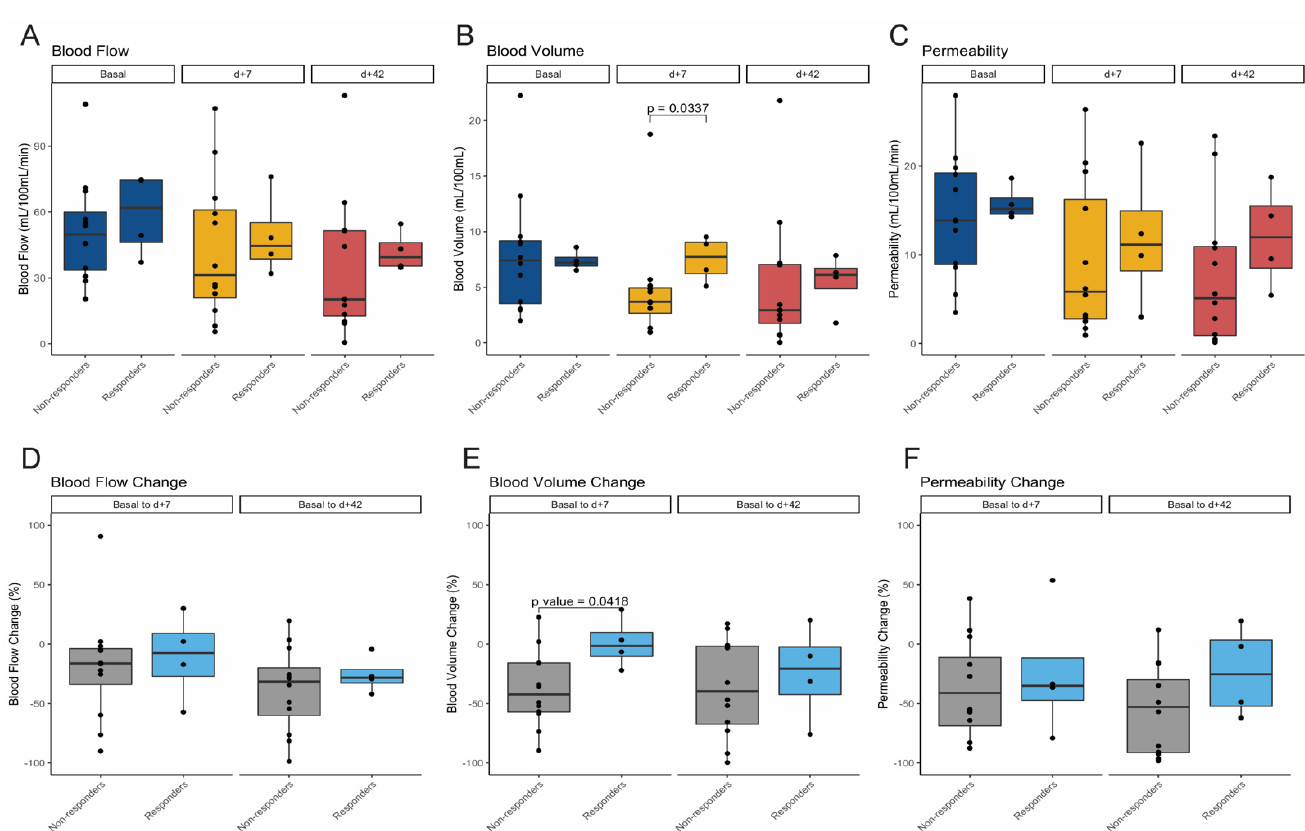
Figure 5. ( A – C ) Boxplots showing values of blood flow ( A ), blood volume ( B ), and permeability ( C ) at baseline, day +7, and day +42 after treatment initiation in non-responder and responder patients according to RECIST v1.1 at day +42. ( D – F ) Boxplots showing relative changes in percentages over time, at day +7, and at day +42 after treatment initiation in terms of blood flow ( D ), blood volume ( E ) and permeability ( F ) in non-responder and responder patients according to RECIST v1.1 at day +42. Table 6. Changes in perfusion parameters in non-responder and responder patients from baseline value. Mean values are shown, with the standard deviation in parentheses.